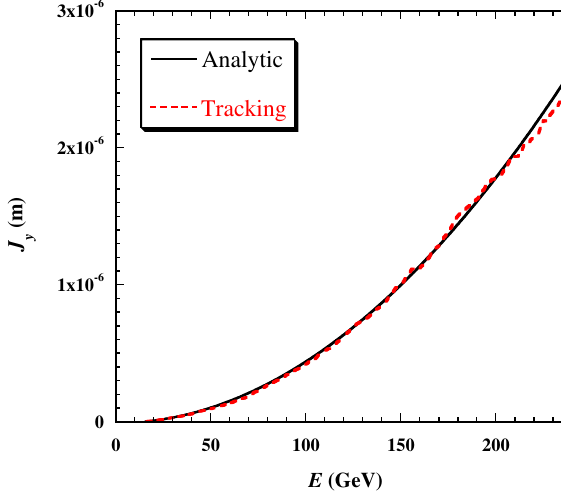
FIG. 3. Action induced by quadrupole magnet offset 1 (cid:10) m (RMS), as a function of beam energy. Results of tracking simulation (solid line) and the analytic formula (dashed line) for the ILC main linac.